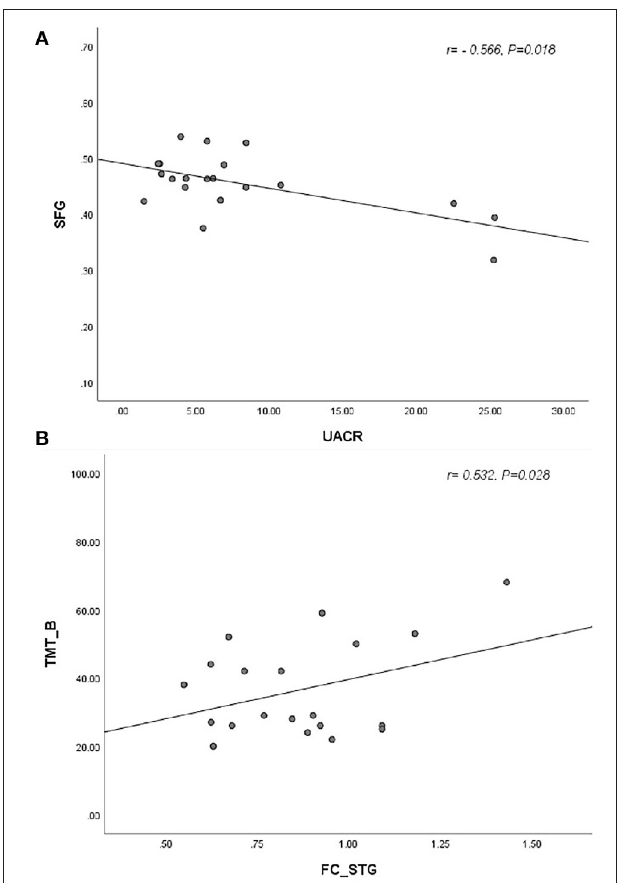
FIGURE 2 | (A) The reduced gray matter volume in SFG was negatively associated with the UACR ( r = − 0.566, p = 0.018). (B) The functional connectivity in STG, insula, and postcentral gyrus was positively correlated with TMT-B ( r = 0.532, p = 0.028). SFG, superior frontal gyrus; UACR, urine albumin creatinine ratio; STG, superior temporal gyrus; TMT-B, trail-making test-B].